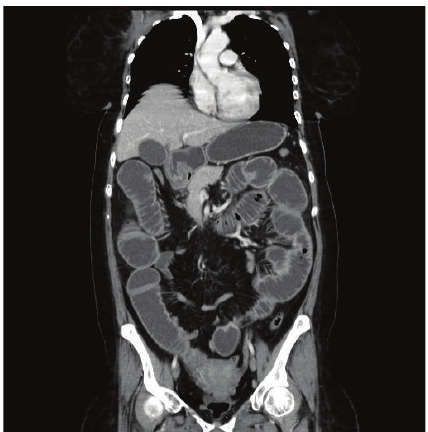
Figure 1: Enhanced coronal CT scan of the abdomen demon- strates mild circumferential wall thickening with luminal narrowing involving the second part of the duodenum associated with sur- rounding fat stranding.